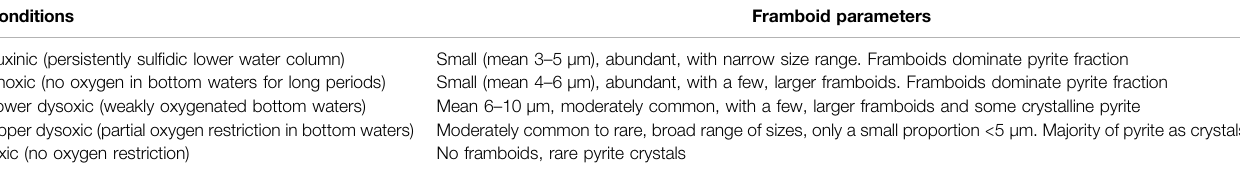
TABLE 2 | Characteristics of framboids used to de fi ne oxygen-related depositional conditions and facies (Bond and Wignall, 2010). Conditions Framboid parameters